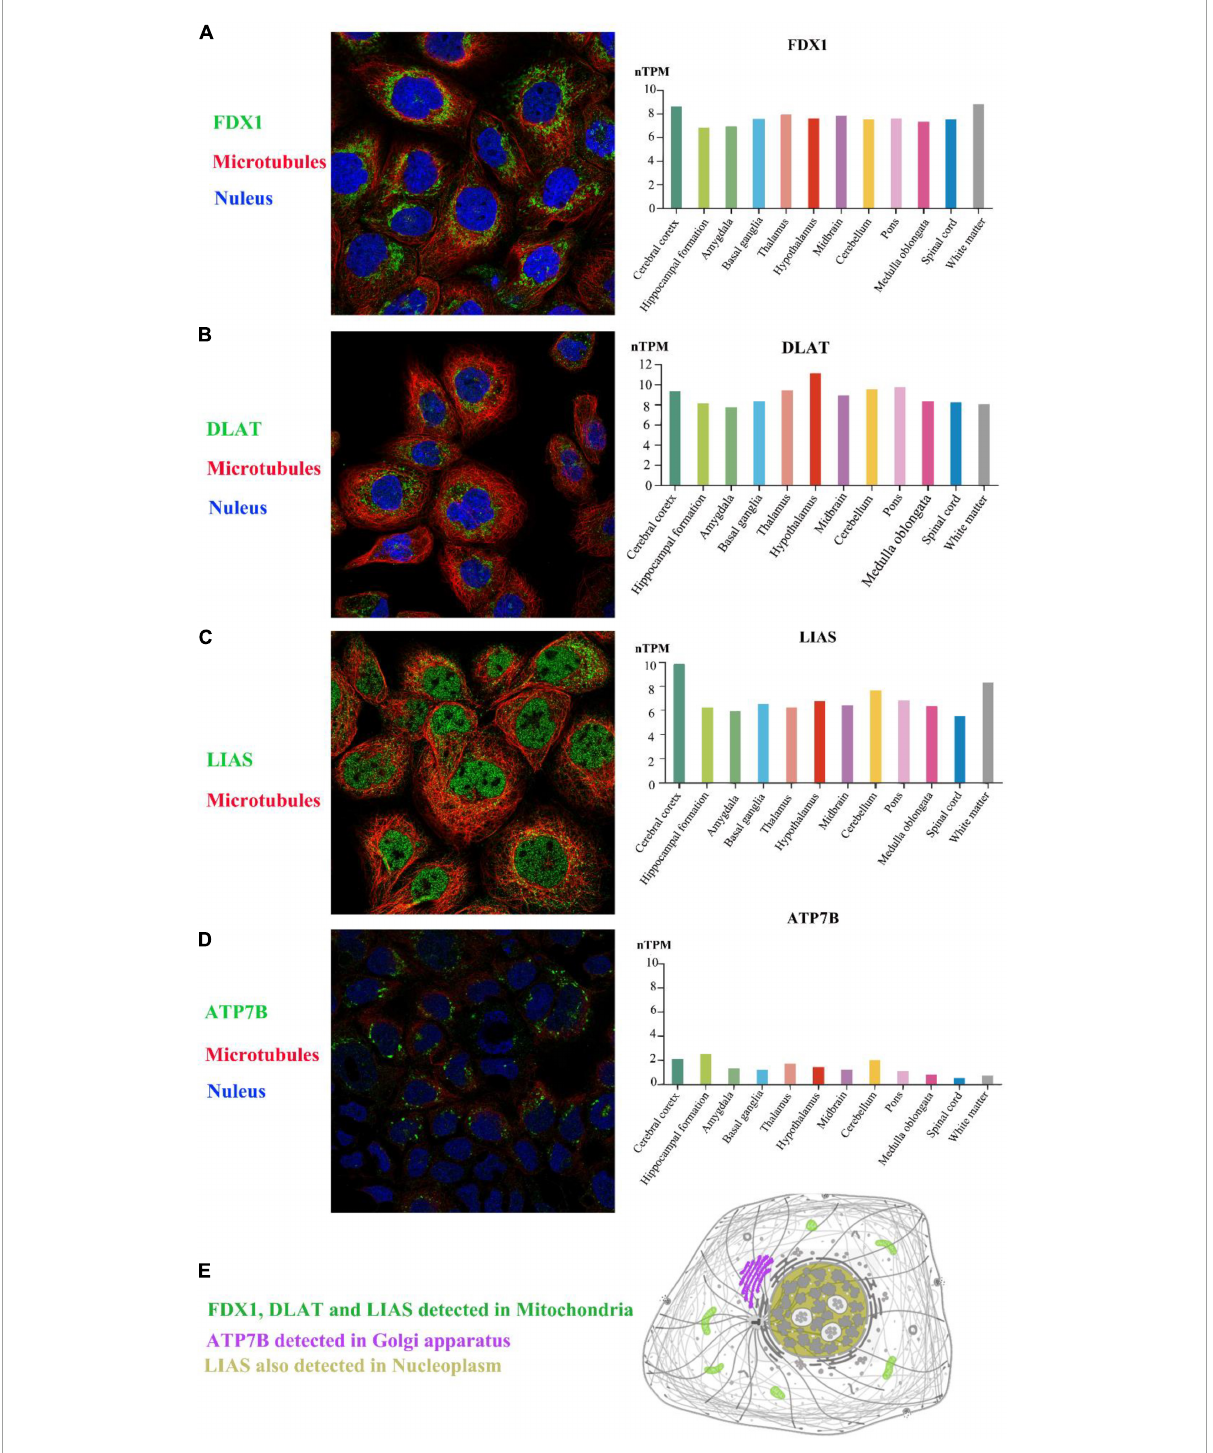
FIGURE3 The expression of selected genes in the brain. Based on the Human Protein Atlas, FDX1, DLAT, LIAS, and ATP7B could all be detected in 12 brain regions. In the A-431 cell line, FDX1 protein and DLAT protein were located in mitochondria (A,B) , and LIAS protein was located in mitochondria and the nucleoplasm (C) . ATP7B protein was also expressed in the Golgi apparatus in the CACO-2 cell line (D) . The schematic graph shows the main location of each protein in cells (E) . The target proteins, nuclei and microtubules were stained green, blue, and red, respectively. nTPM, normalized transcript expression